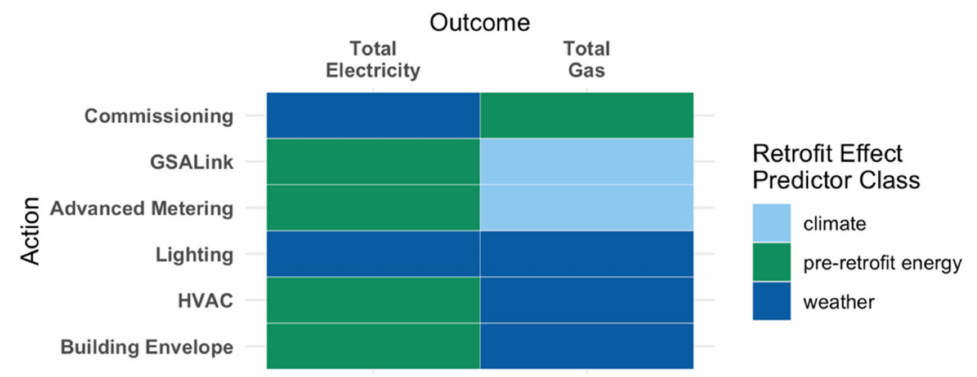
Figure 20. Most important retrofit effect predictor categories for level-2